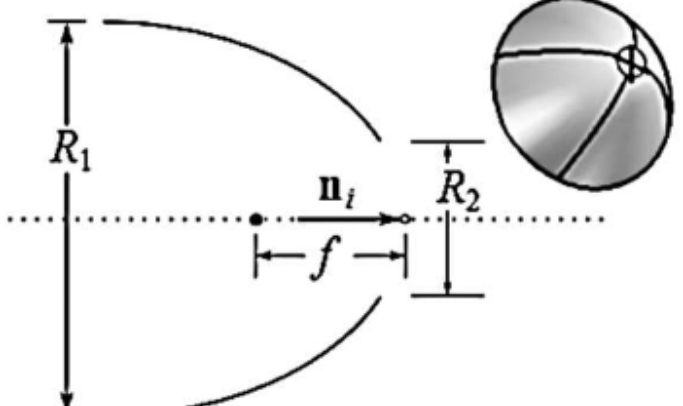
Figure 1. Shell 3D: thin-layer parabolic mirror.